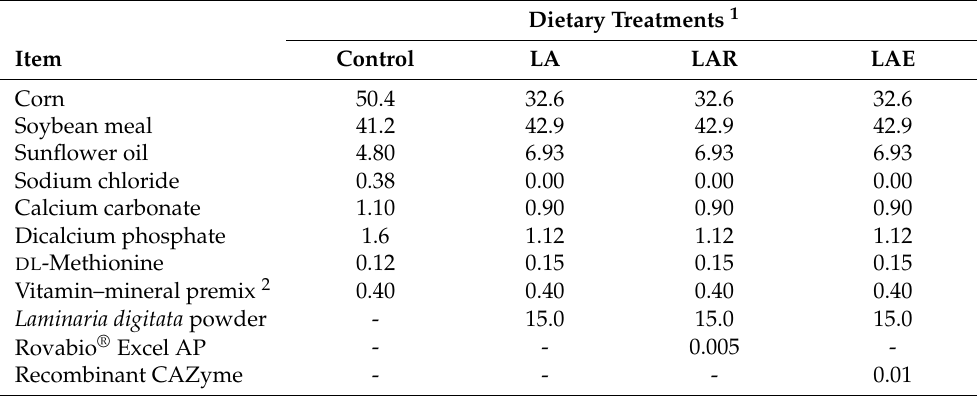
Table 1. Ingredients and feed additives of the experimental diets (percentage as fed